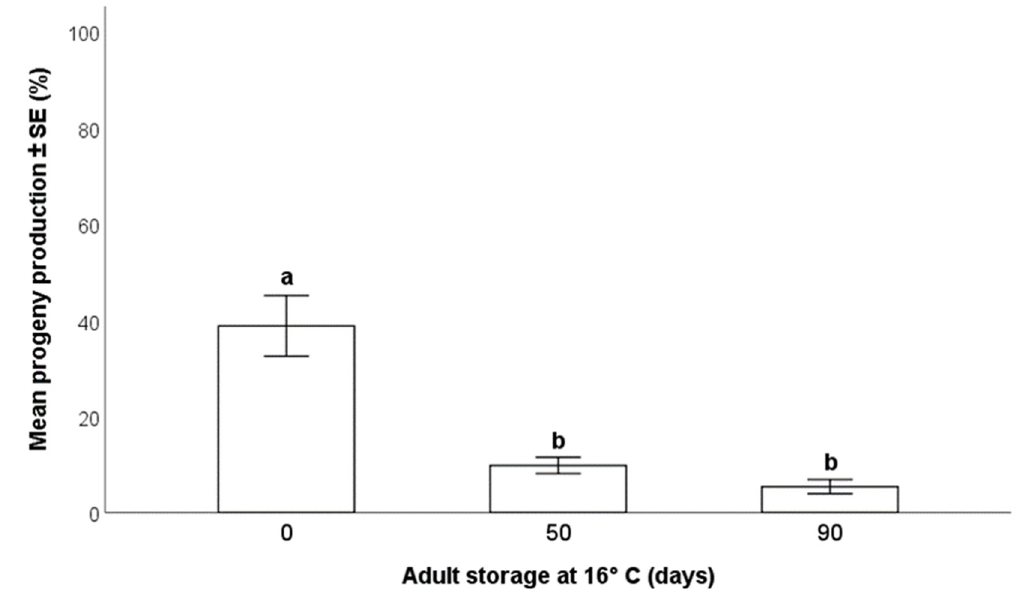
Figure 7. Effects of the length of storage at 16 ◦ C of Trissolcus japonicus adults on the production of progeny (GLM, p < 0.001). Egg masses of Halyomorpha halys were stored at − 24 ◦ C for ≈ 9 months prior to exposure to wasps. Different letters indicate significant differences ( p < 0.05) as detected by multiple comparison with sequential Bonferroni adjustment.